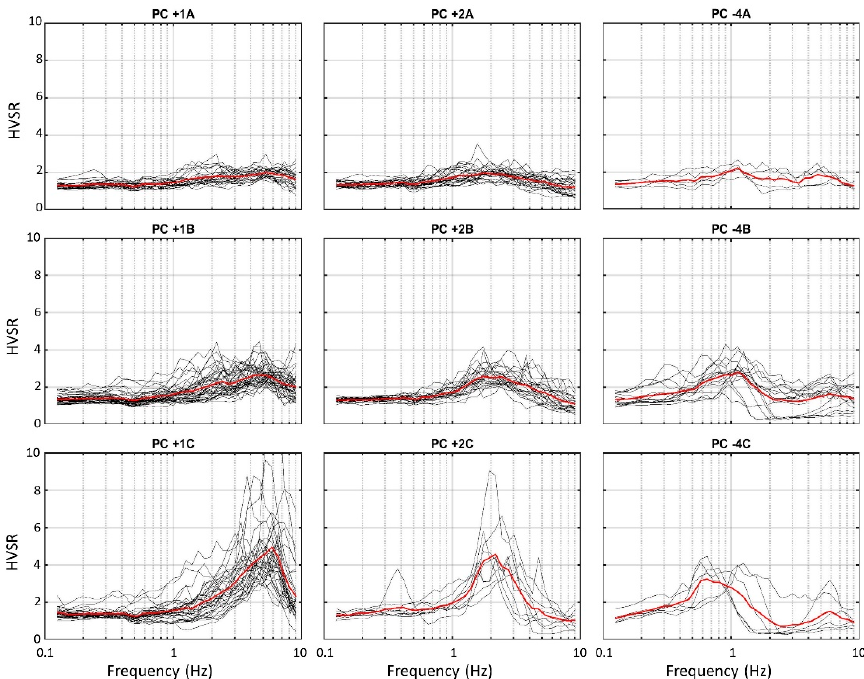
Figure 6. Experimental (black lines) and respective group-average (red lines) curves corresponding to the PC classes characterized by F 0 values in the frequency range of 0.65–5.5 Hz (PC+1, PC+2 and PC-4) by also considering the respective amplitude subclasses (A, B and C).